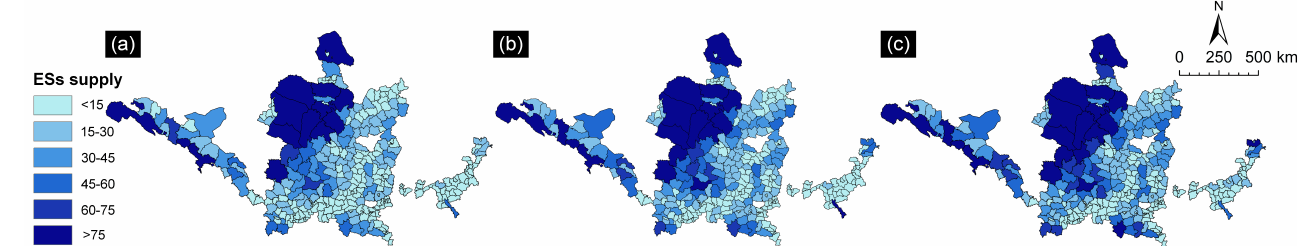
Figure 2. Spatial distribution map of ESs supply in resource-based cities in the YRB from 2000